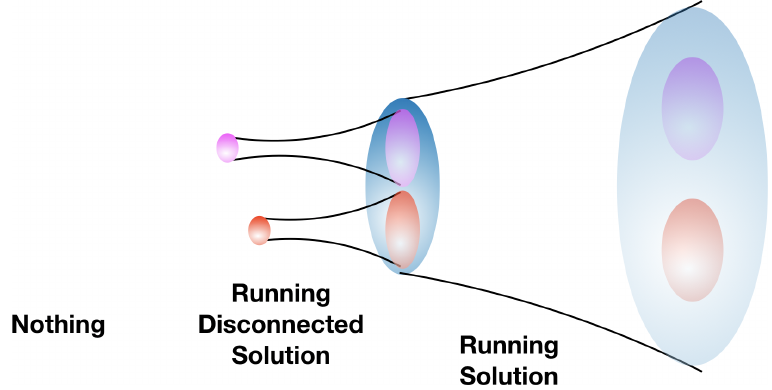
Figure 6 . Picture of a bifid throat. It represents a domain wall implementing a cobordism between one theory and a disconnected set of two quantum gravity theories.